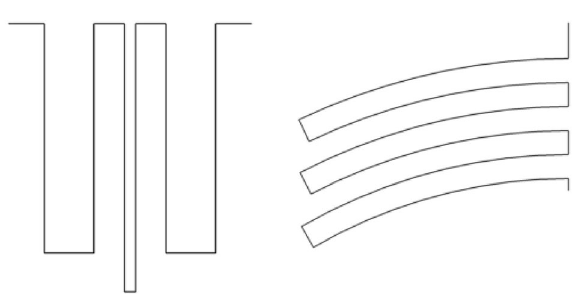
Figure 6. Two path coils with different shape ( a ) square shape path coils ( b ) radial circular shape path coils.